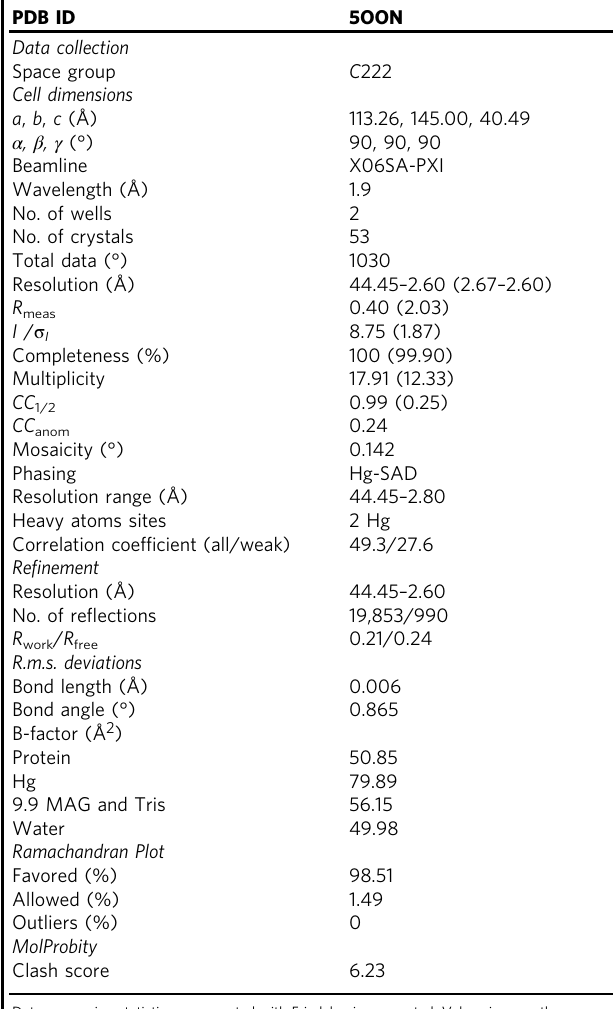
Table 1 Data collection and re fi nement statistics for